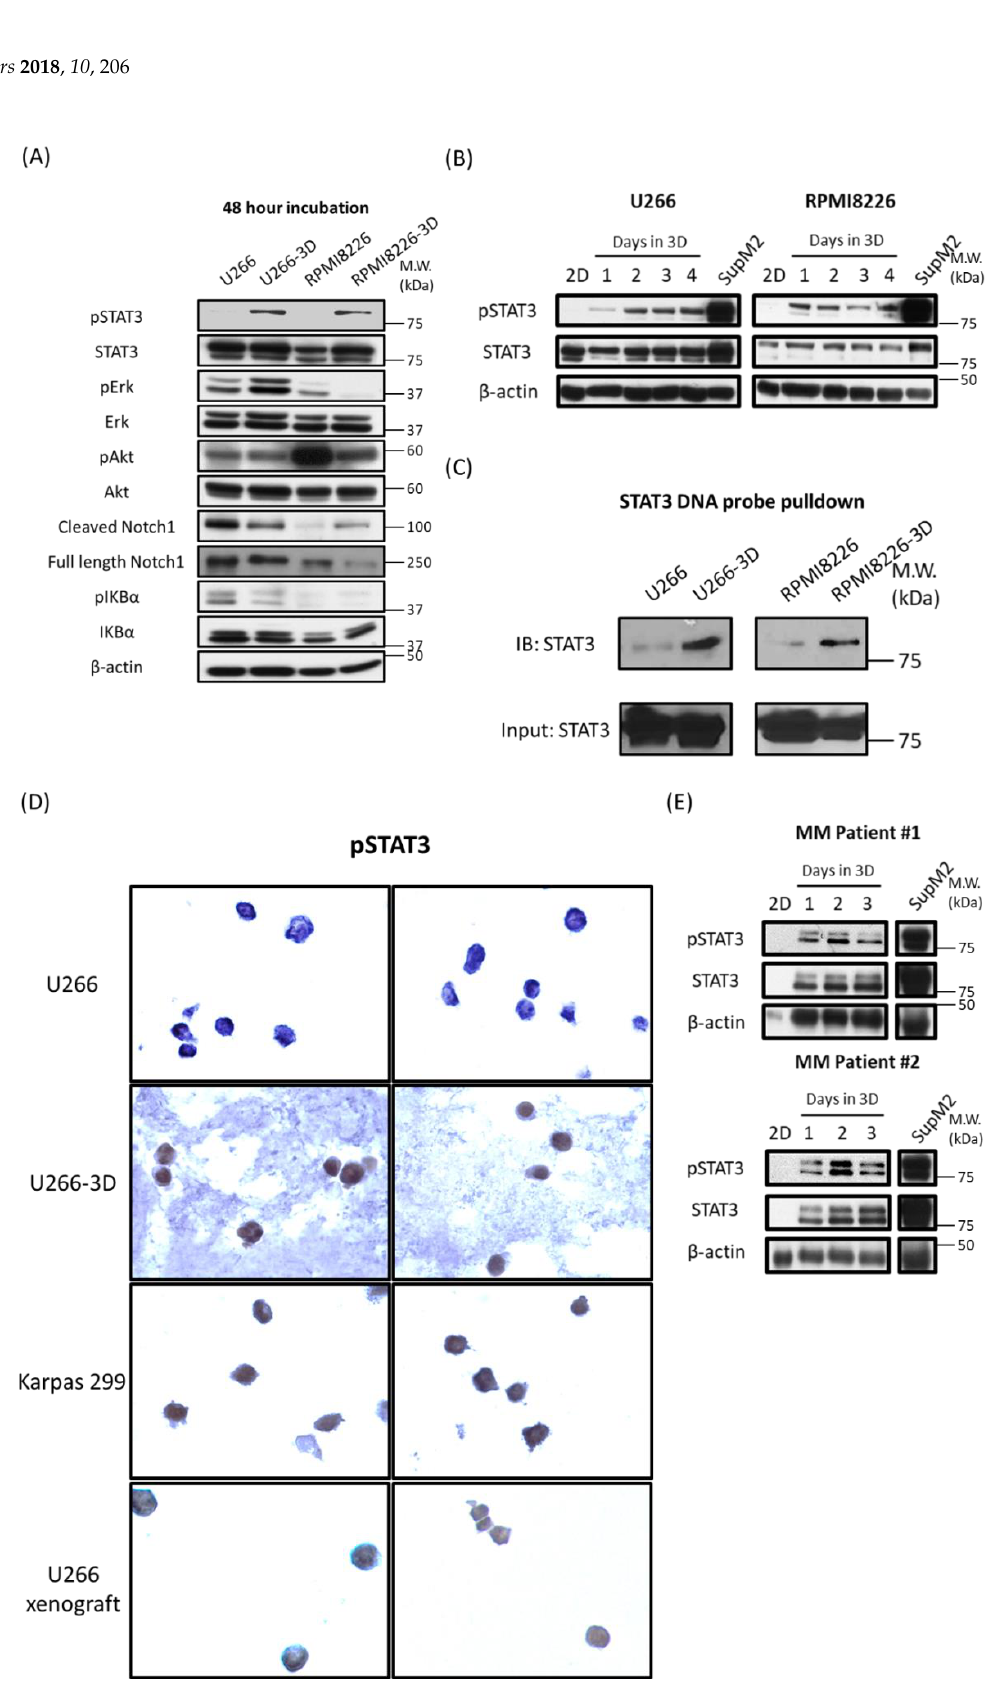
Figure 2. MM cells cultured in 3D acquire STAT3 activity. ( A ) The activity of various signaling pathways (STAT3, Erk/MAPK, PI3K/Akt, NF- κ B and Notch) in U266 and RPMI8226 cells cultured conventionally (2D) or in 3D was examined by Western blot analysis after 48 h; ( B ) The STAT3 activity of U266 and RPMI8226 cells in 2D or 3D culture from day 1 to day 4 were examined by Western blot analysis of pSTAT3 levels. SupM2 cells were included as a positive control for the pSTAT3 level; ( C ) The DNA binding ability of STAT3 in U266 and RPMI8226 cells cultured in 2D or 3D was examined by DNA pulldown immunoblotting assay. The cells were harvested and lysed after 48 h in culture. STAT3 in cell lysate was pulled down by a STAT3 DNA probe (described in Materials and Methods); ( D ) Immunocytochemical analysis of pSTAT3 level in U266, U266-3D, Karpas 299 and U266 xenograft cells. The cells were fixed after 48 h in culture. The procedure of processing, embedding and sectioning was described in Materials and Methods. Two representative pictures were shown. Karpas 299 cells were included as a positive control for pSTAT3 staining; ( E ) Western blot analysis of pSTAT3 and STAT3 levels of primary MM bone marrow cells in 2D or 3D culture from day 1 to day 3. SupM2 cells were included as a positive control for pSTAT3 level. β -actin was probed as a loading control in each